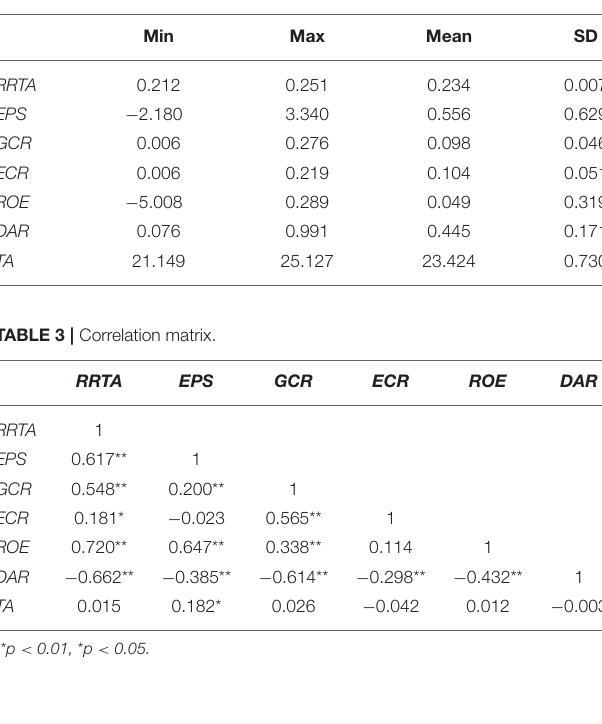
TABLE 4 | Results of regression